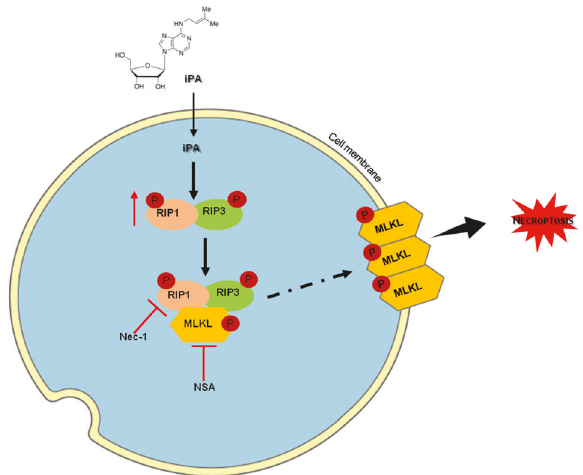
Fig. 7 iPA induces necroptosis in GBM cell lines. As showed in our work, iPA can rise the levels of the phosphorylated, and thus activated, forms of RIP1 and RIP3 kinases. The activated proteins can interact with each other forming the necrosome protein complex. The necrosome in turn phosphorylate MLKL, that translocate to the plasma membrane to promote necrosis by disrupting the integrity of cell membrane. Necrostatin-1 (RIP1 inhibitor) and Necrosulfona- mide (MLKL inhibitor) were used in this work to prove the induction of necroptosis in GBM treated cell lines by